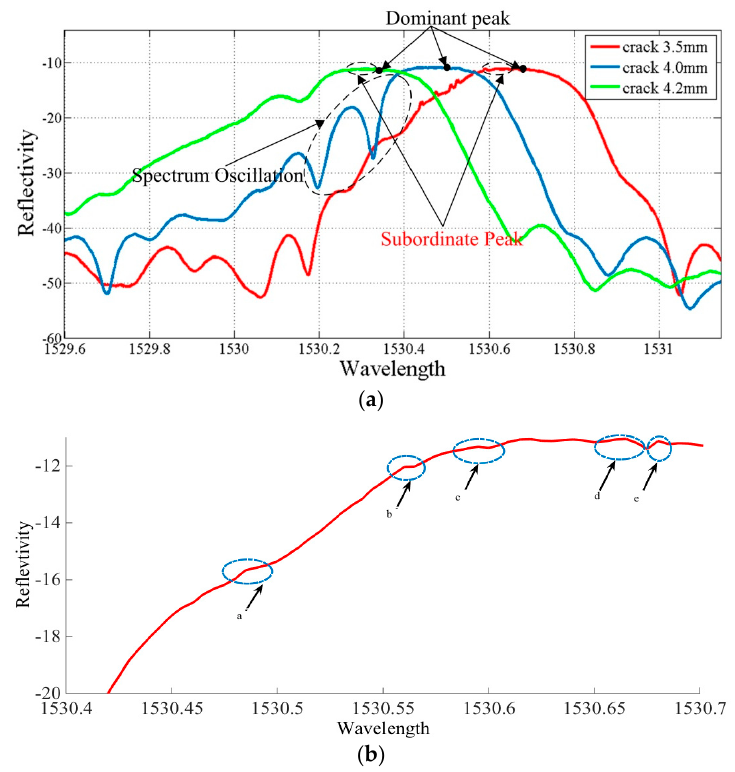
Figure 4. Variety of physical parameters with different crack lengths. ( a ) The global curve at different crack lengths; and ( b ) the subordinate peaks with a 3 db decline near the main peak.